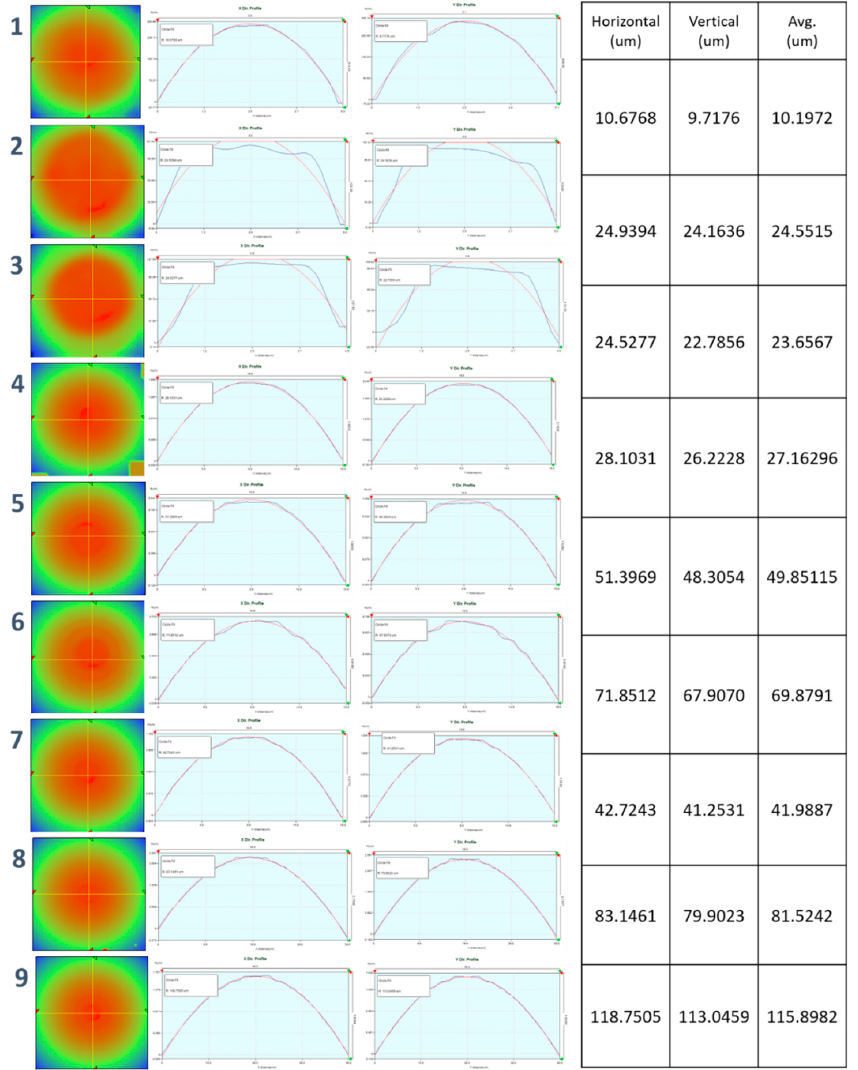
Figure A10. 3D profiler measurement data for 5th replica of the final product (OrmoClear FX).